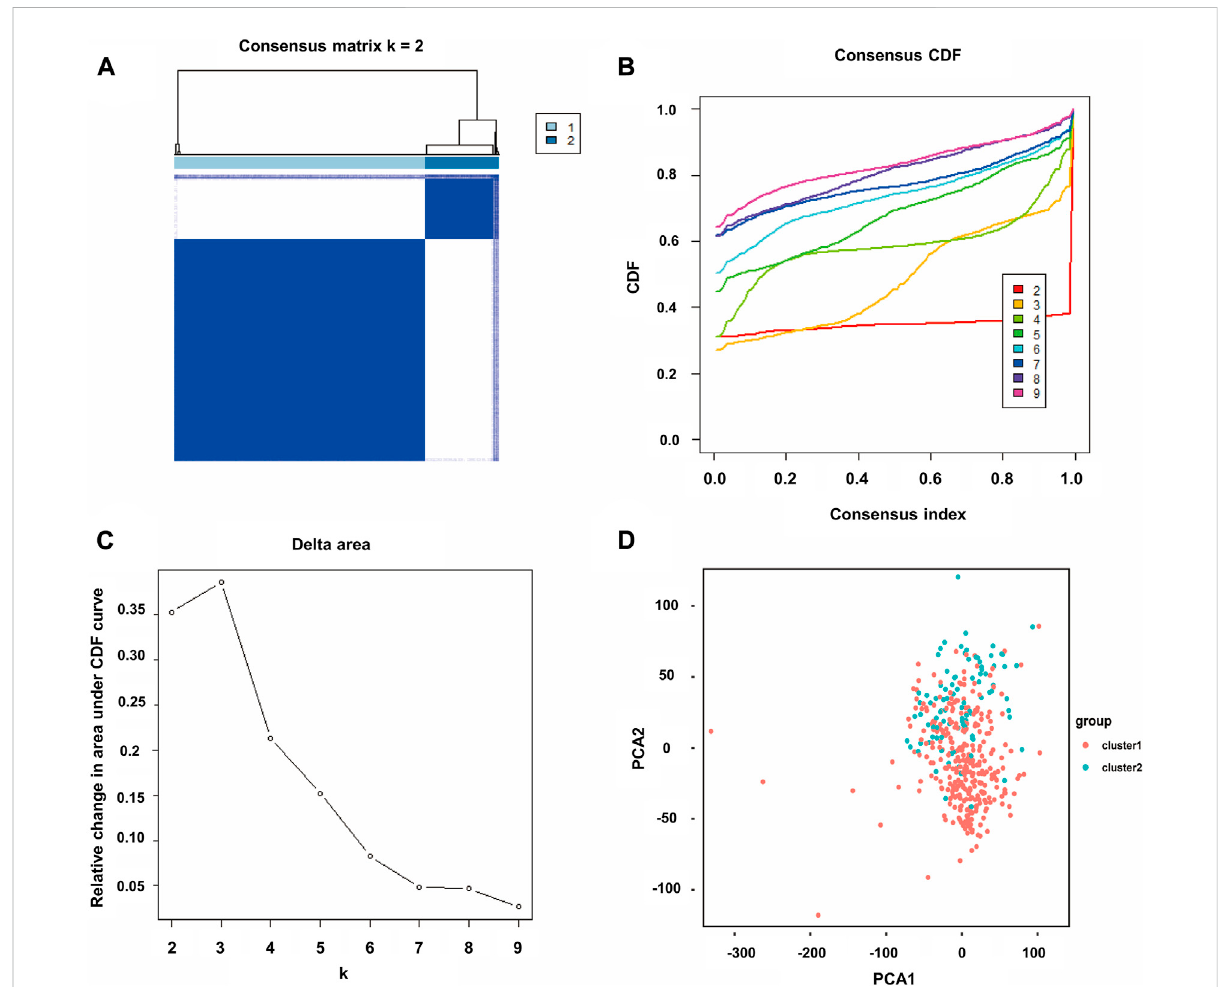
FIGURE 1 Consensus clustering of BLCA. (A) Correlation between subgroups when consensus matrix number k = 2. (B) Cumulative distribution function (CDF)isdisplayedfork=2 – 9. (C) RelativechangeintheareaundertheCDFcurvefork=2 – 9. (D) Principalcomponentanalysis(PCA)oftheRNA-seq data. Red dots represent cluster 1, and cyan dots represent cluster